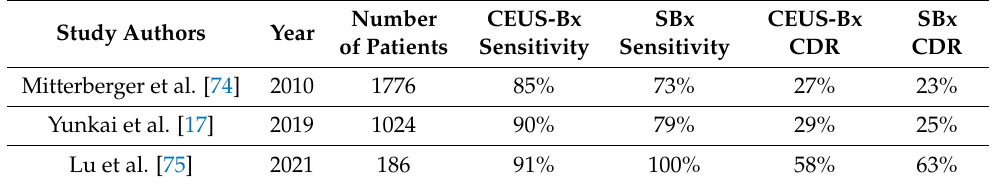
Table 4. Comparison of CEUS-Bx and SBx performance in the detection of